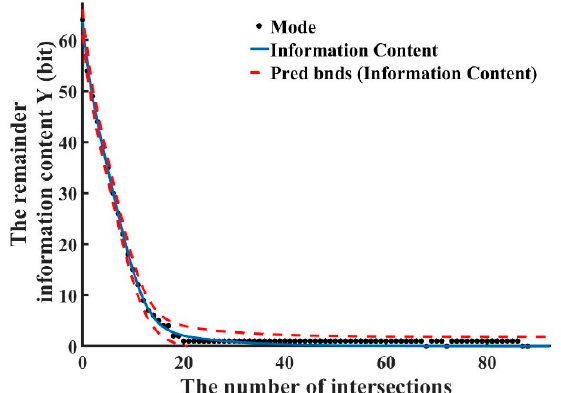
Figure 9. The relationship between the remaining information content and the number of intersections.